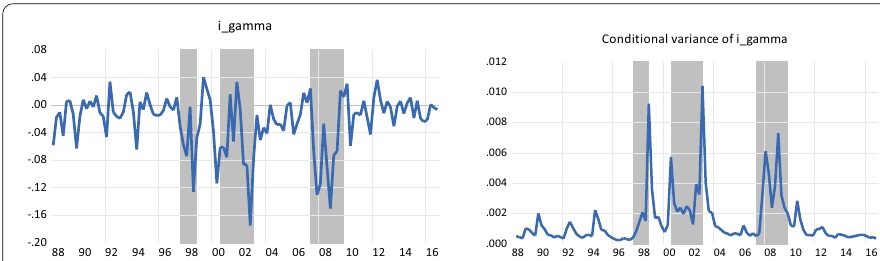
Fig. 4 Innovation in aggregate liquidity ( i_gamma ) and conditional variance of i_gamma, 1988Q1‑2016Q2. Notes: These plots reproduce the innovation in aggregate illiquidity ( i_gamma ), as published by Pástor and Stambaugh (2003), and its conditional variance. The conditional variance is computed using the EGARCH method in order to account for the asymmetries in the behavior of i_gamma dependent of the phase of the business cycle. Shaded areas correspond to periods of